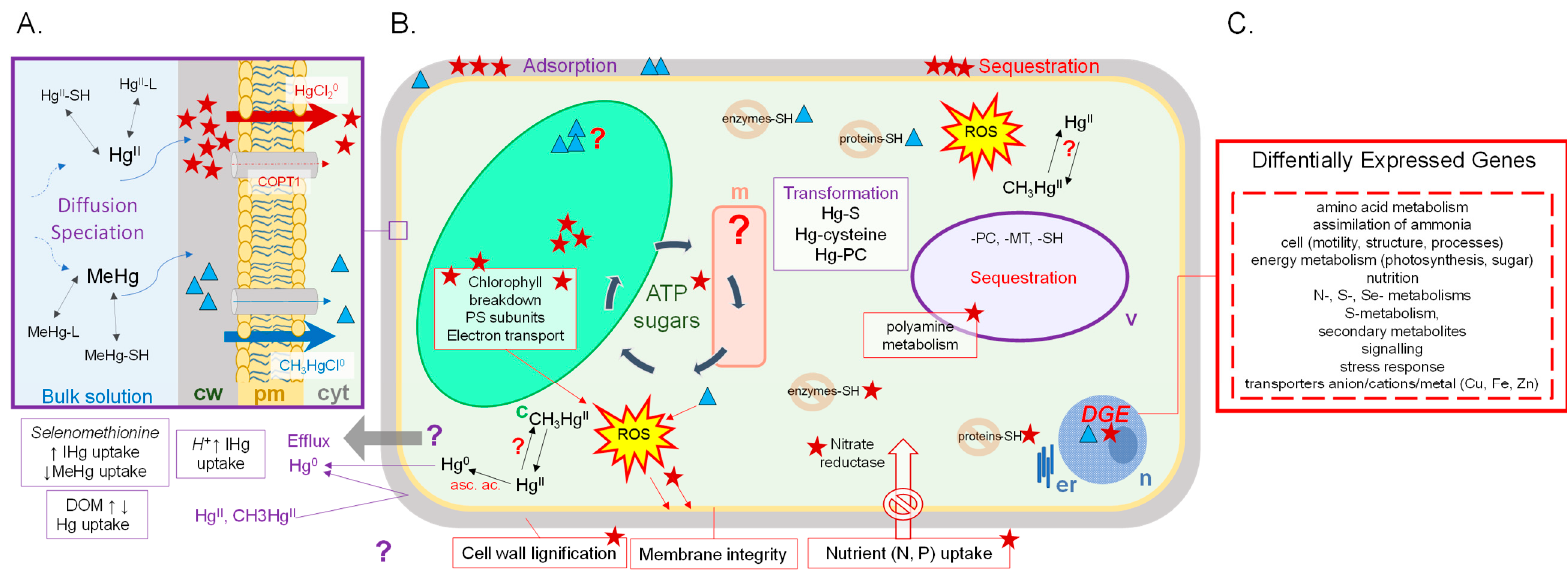
Figure 1. Summary of the current concepts on IHg (star) and MeHg (triangle) uptake ( A ), effects ( B ) and transcriptomic response ( C ) in cells of aquatic primary producers (c, chloroplast; cyt, cytosol; cw, cell wall; er, endoplasmic reticulum; m, mitochondrion; n, nucleus; pm, plasma membrane; v, vacuole; other definitions in the text).